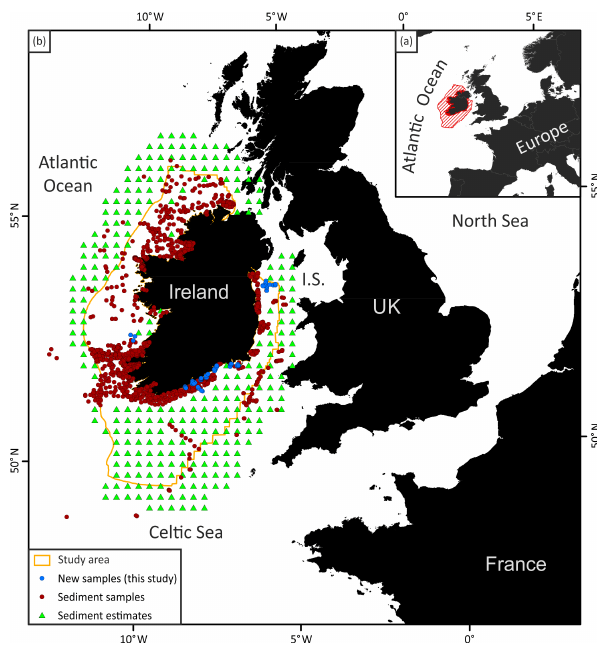
Figure 1. (a) Location map showing the study area (red hatched area) and part of western Europe. (b) Map of the study area bound- ary (orange line) and all the data points used in this study. I.S.: Irish